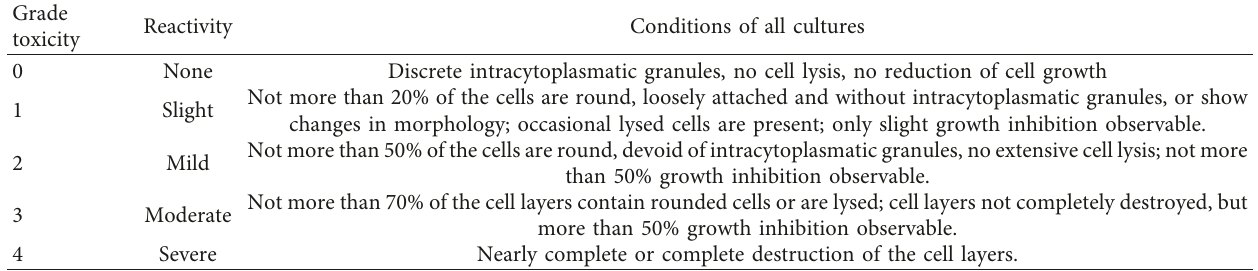
Table 2: Criteria of toxicity effect based on changes in cell morphology according to EN ISO 10993–5:2009. Grade